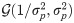
Log-transformed ensemble spread and potential prediction utility (PPU) for stochastic forcing and initial error.We generated 1,000 synthetic outbreaks forced by daily absolute humidity for New York City. Perturbations were imposed at a given time relative to the outbreak peak (-70 days to 42 days); the evolution of log-transformed ensemble spread (base e) for the following 6 weeks (42 days) is displayed. A negative/positive perturbation time indicates the model is perturbed before/after the peak. Perturbations were generated from a gamma distribution G(1/σp2,σp2) for stochastic forcing (A) and a Gaussian distribution N(1,σp2) for initial error with a standard deviation of σp = 10% (B). Stochastic forcing and initial error lead to similar growth patterns, but initial error exhibits faster growth. The same analysis for PPU is displayed in (C-D). The log-transformed ensemble spread and PPU are averaged over the results from 1,000 synthetic outbreaks. In general, PPU decreases much faster for initial error than stochastic forcing.